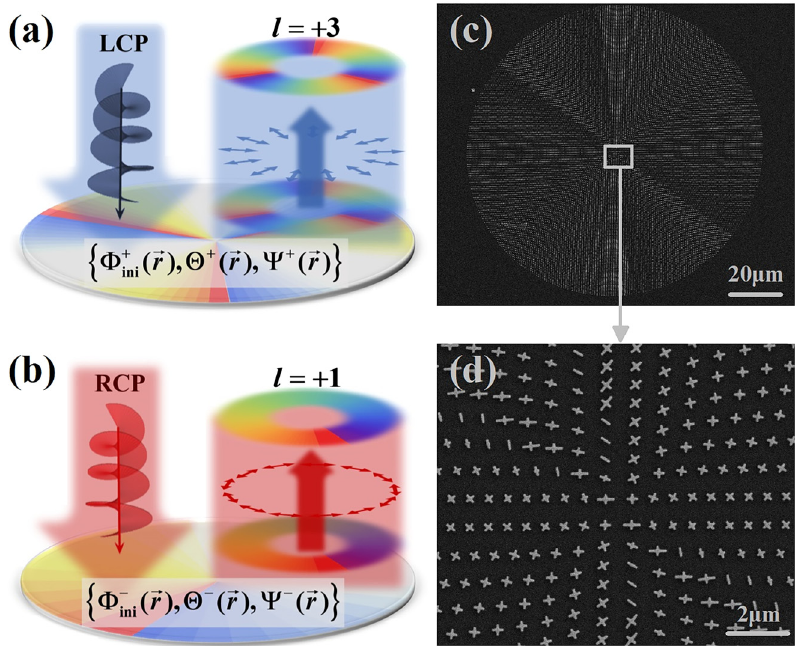
Figure 4: Expected bifunctionalities of metadevice I and its sample